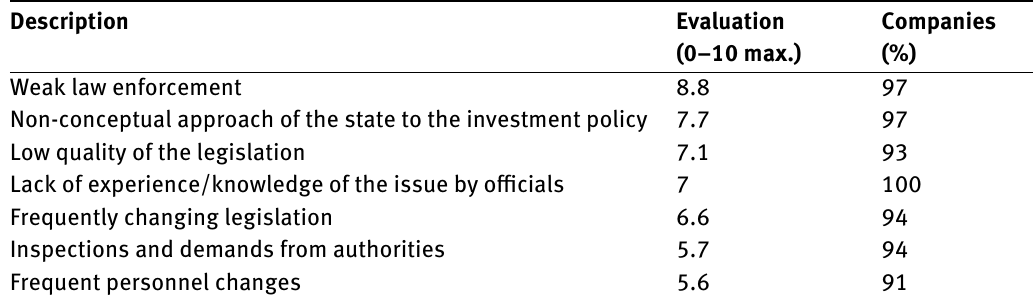
Table 3: Results of the research of CEEC Research regarding the legislation of the Slovak Republic.